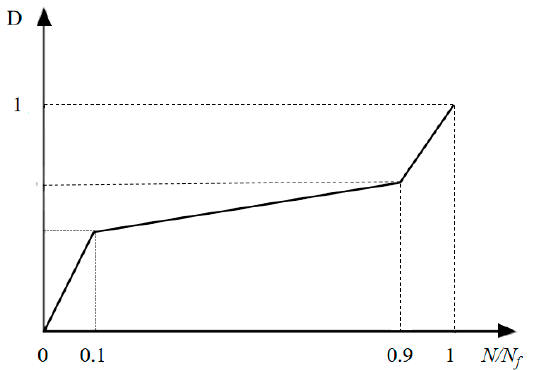
Figure 8. Three-stage simplified diagram of track slab under fatigue load.